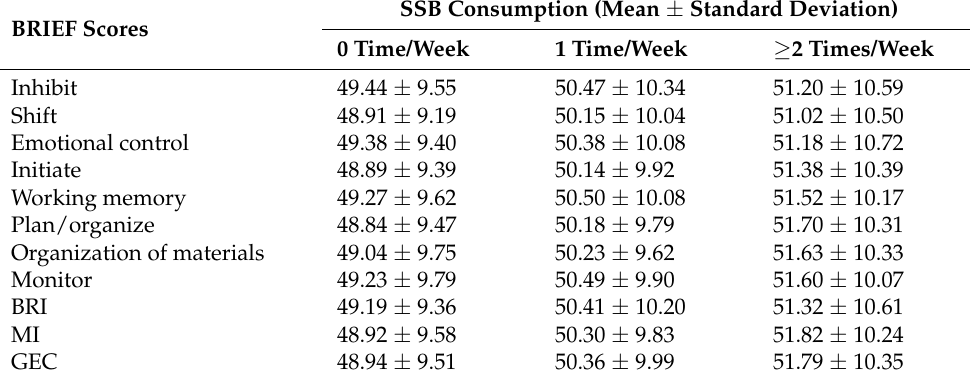
Table A1. The distribution of scores of BRIEF among SSB consumption ( n =